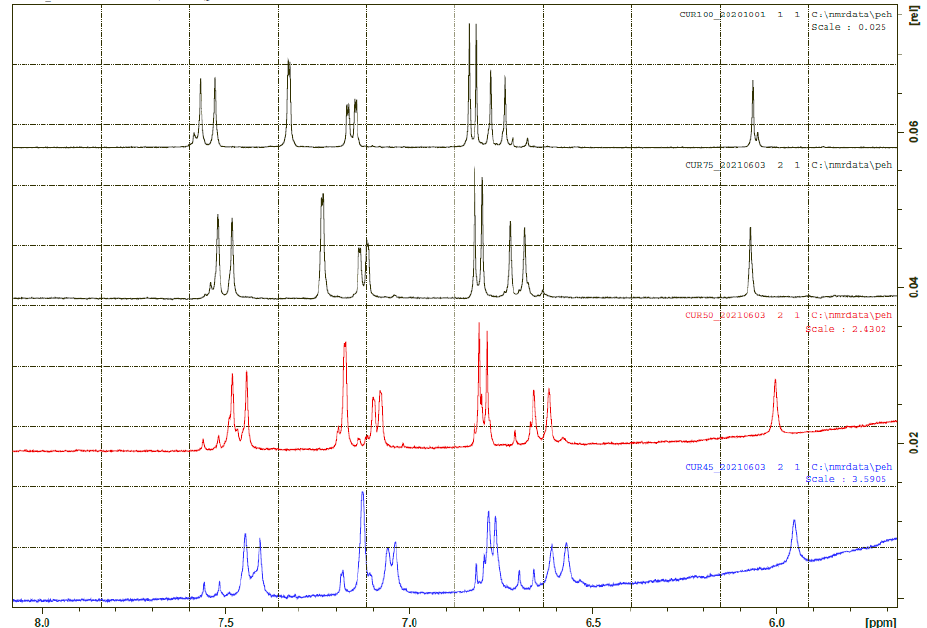
Figure 5. 1 H NMR spectra of curcumin in a mixture of H 2 O and DMSO-d 6 . From top, 0%, 25%, 50%, 55% H 2 O. The major form is the enol-form. The diketo-form is seen as the minor resonances. Table 3. pKa values and equilibrium constants for enol to keto-forms. Data from [29] with permis- sion from Canadian Science Publication.